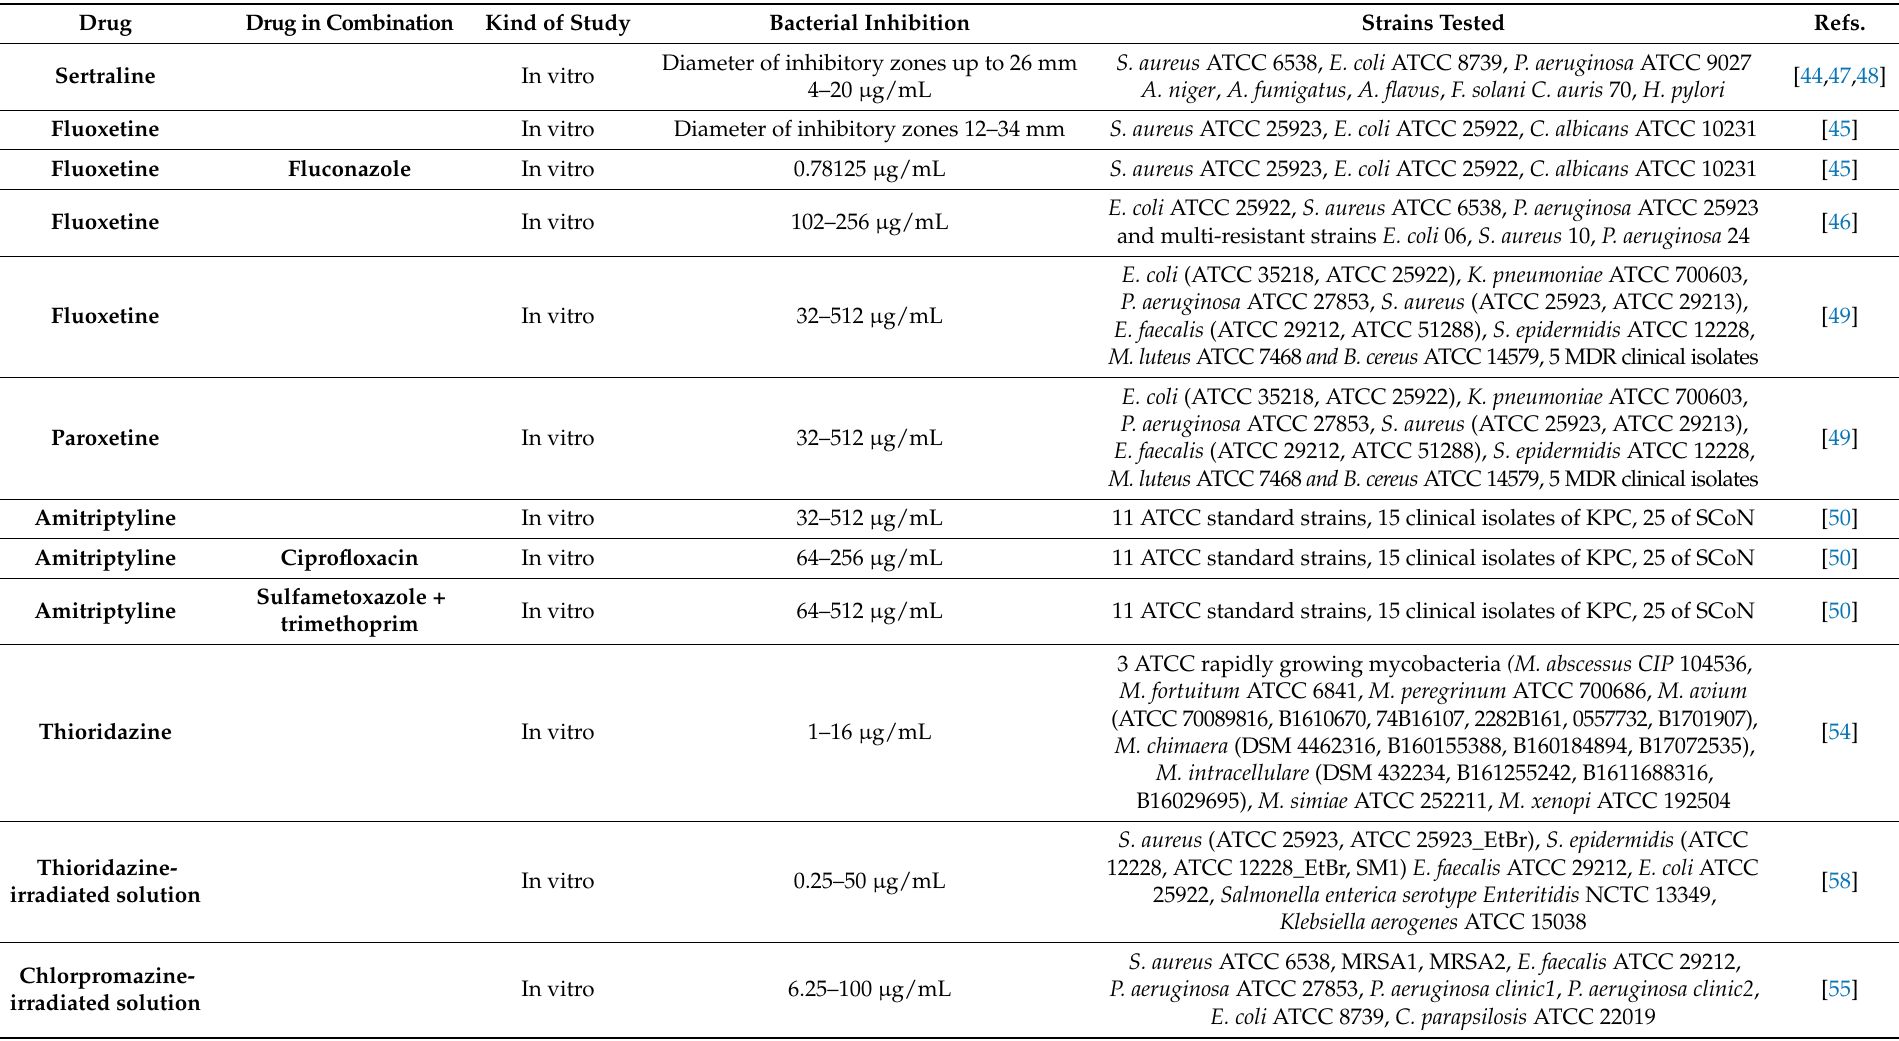
Table 2. Antimicrobial activity of antidepressants and antipsychotic